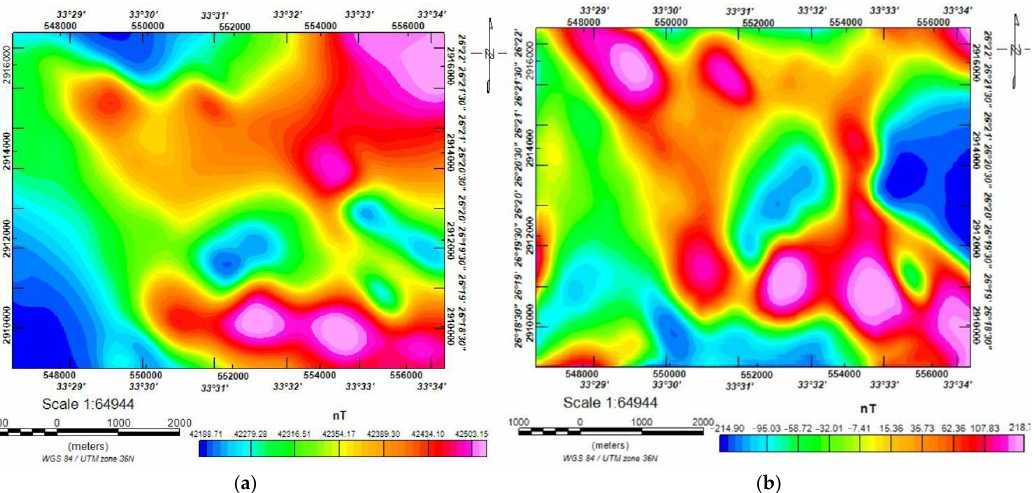
Figure 5. ( a ) Total magnetic intensity (TMI) map and ( b ) Reduction to North Pole (RTP) map of the study area.